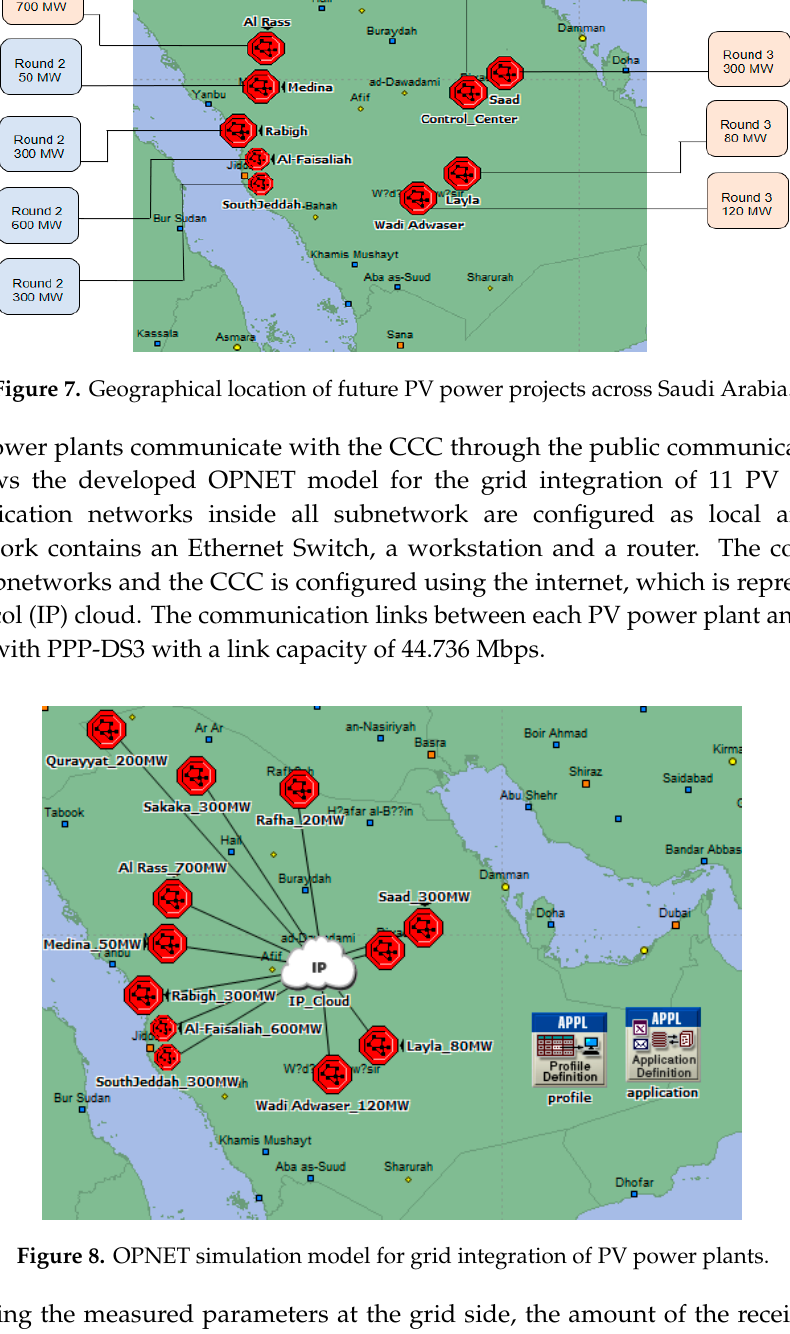
Table 11. Summary of future PV power projects in Saudi Arabia [20]. Round